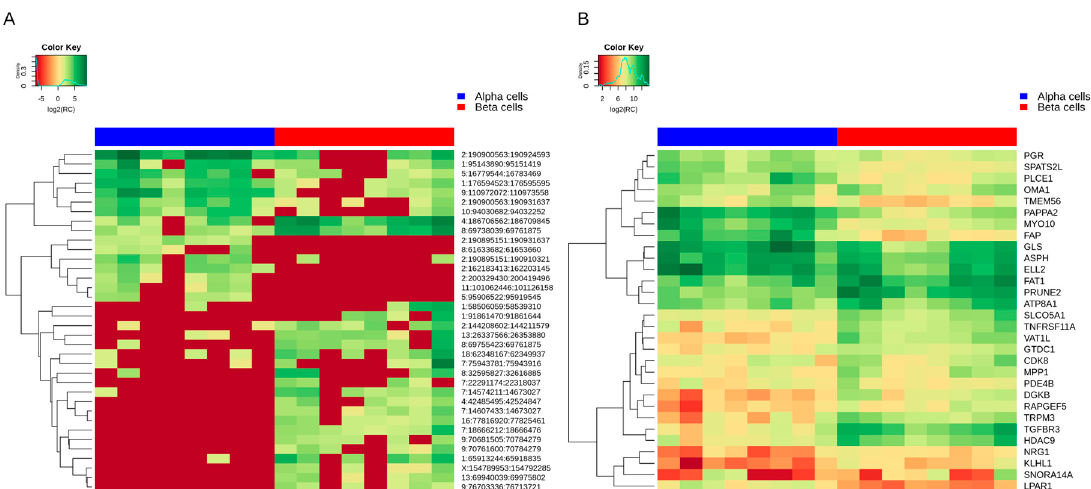
Figure 5. Expression profiles of differentially expressed candidates. Heatmap of normalized expression (log2 RC) of differentially expressed circRNAs ( A ) and their host mRNAs ( B ) in α - and β -cells.